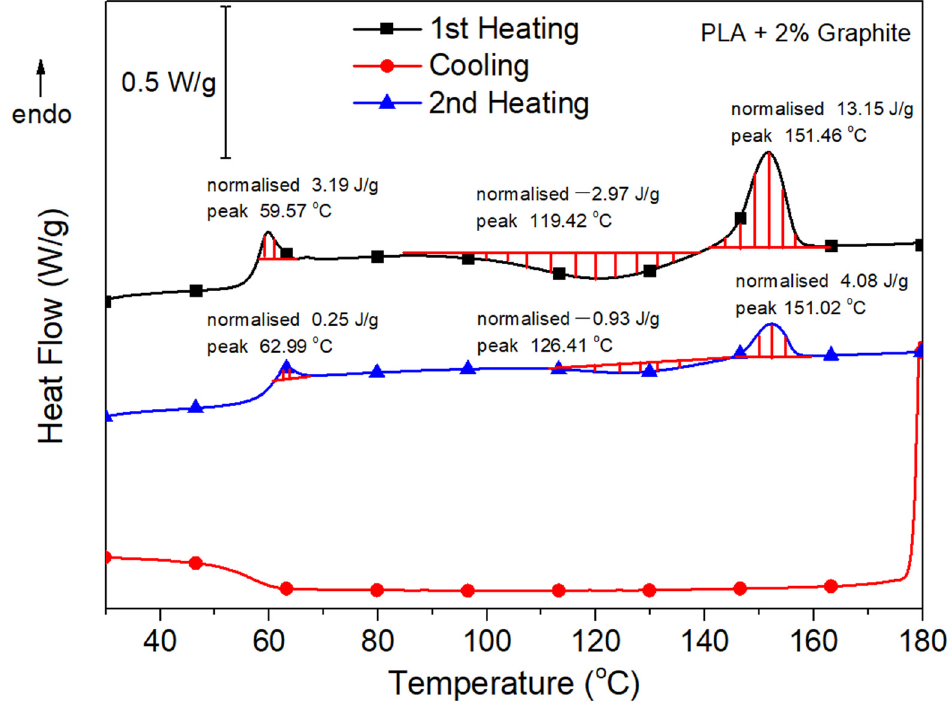
Figure 8. DSC curve of PLA + 2% graphite filament.